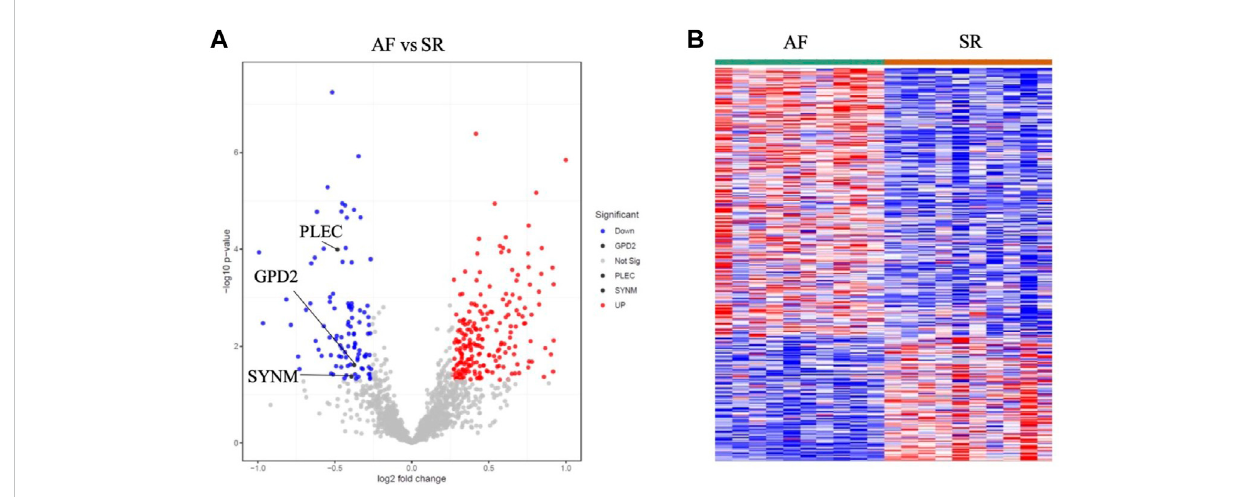
FIGURE 6 Proteomics pro fi ling analysis of AF and SR samples showing the downregulation of GPD2, PLEC and SYNM in the volcano plot (A) and heatmap (B) .